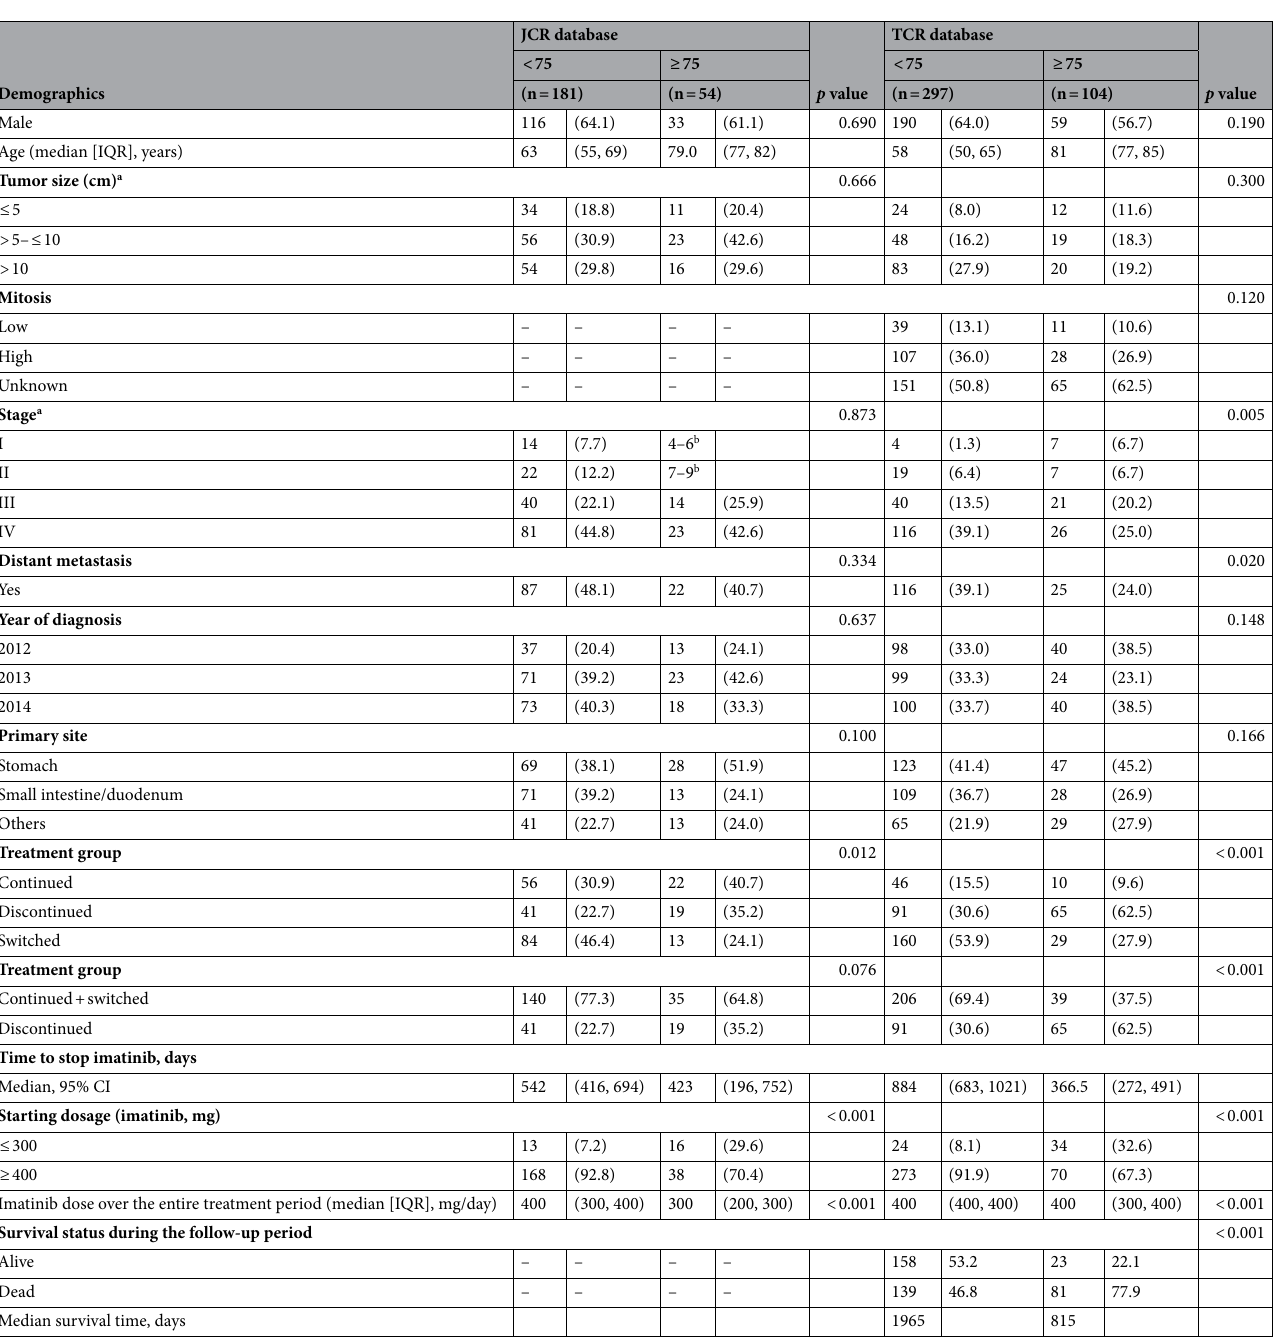
Table 3. Demographics of patients in the advanced/metastatic setting after stratification by age. JCR Japanese Cancer Registry, TCR Taiwan Cancer Registry, CI Confidence interval, IQR Interquartile range, SD Standard deviation. a Unknown is removed from staging and tumor size. b Any patient group with a size below 10